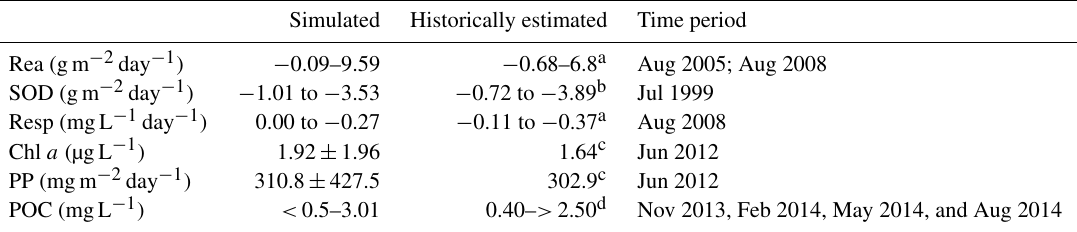
Figure 7. Comparisons of the simulated (coloured map) and the observed (coloured dots) DO concentrations at the bottom layer during July and August 2006. Table 3. Comparisons between the simulated and historically estimated values during summer at the Lingdingyang Bay: re-aeration rate (Rea); sediment oxygen demand (SOD); respiration rate (Resp); chlorophyll a (Chl a) concentrations; primary productivity (PP); partic- ulate organic carbon (POC) concentrations. Note that positive values represent DO production rates, while negative values represent DO consumption